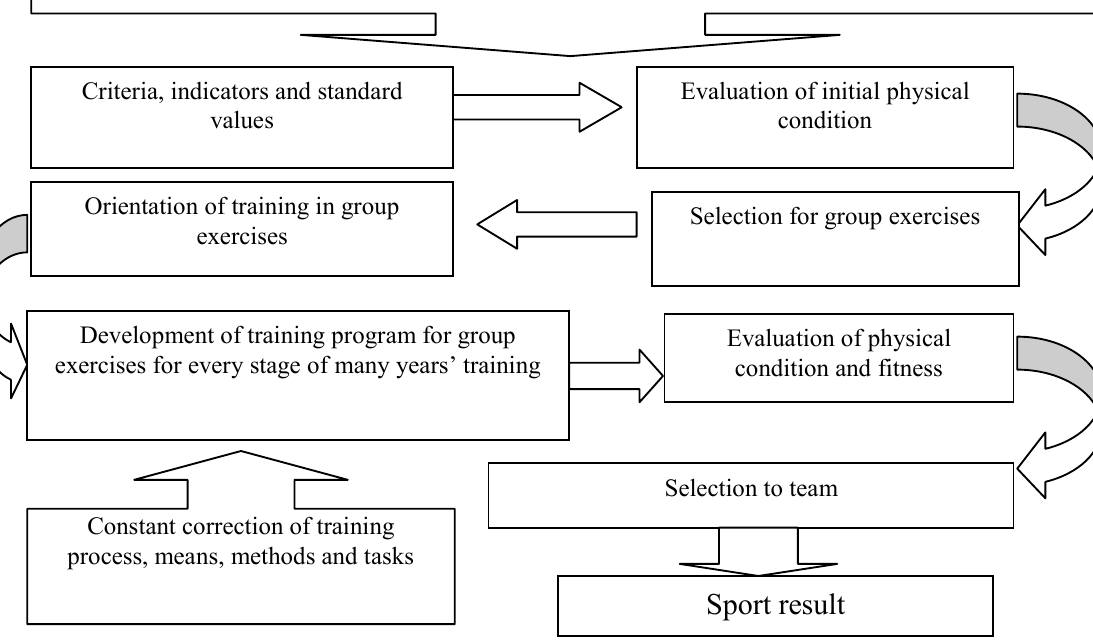
Fig.2. Structural diagram of selection technology, orientation and training of sportswomen for group